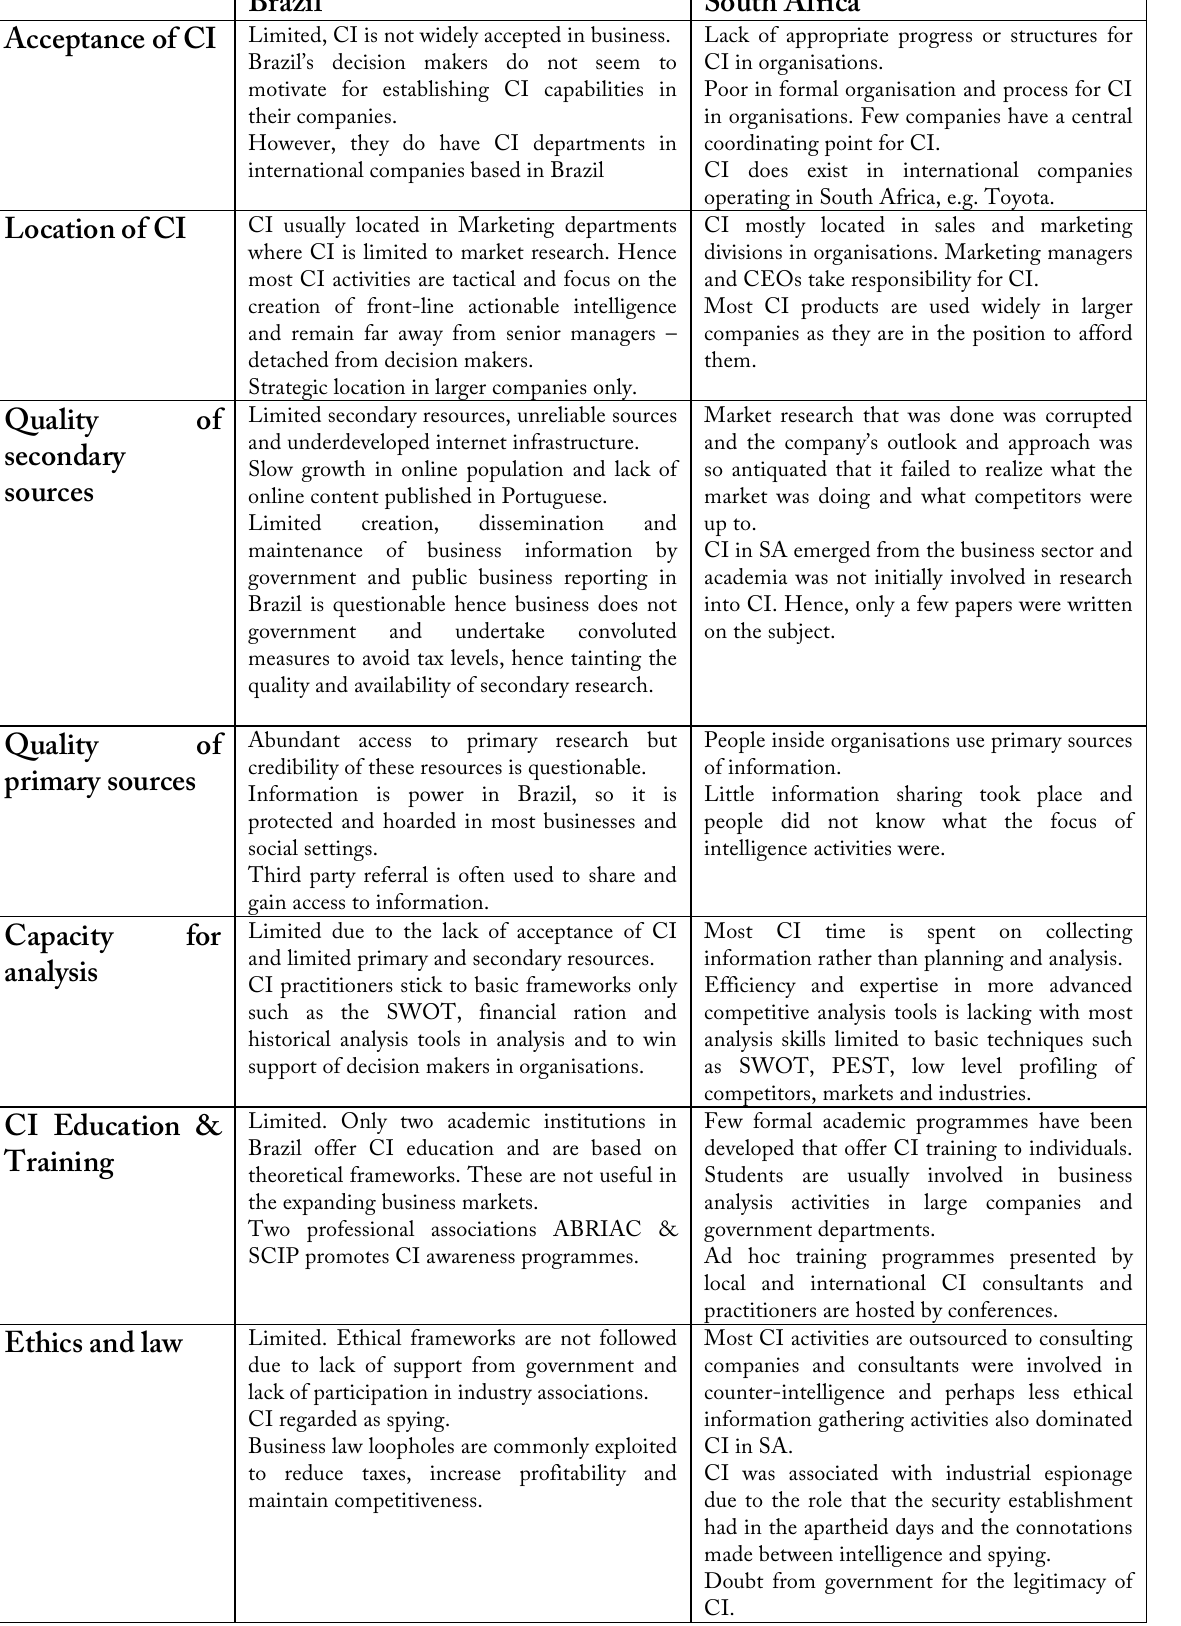
Table 1. Competitive intelligence: Brazil versus South